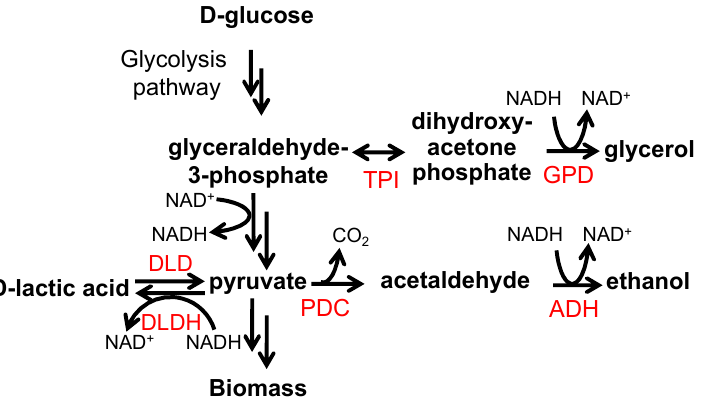
Figure 4. Production of D -lactic acid from glucose. The expression of a D -lactate dehydrogenase (DLDH) enzyme from lactic acid bacteria results in the production of D -lactic acid from pyruvate. By decreasing the production of ethanol and glycerol and limiting the degradation of D -lactic acid, the amount and yield of D -lactic acid can be increased. DLDH, lactic acid bacteria D -lactate dehydrogenase; DLD, endogenous D -lactate dehydrogenase; ADH, alcohol dehydrogenases; PDC, pyruvate decarboxylase; TPI, triosephosphate isomerase; and GPD, glycerol-3-phosphate dehydrogenases.